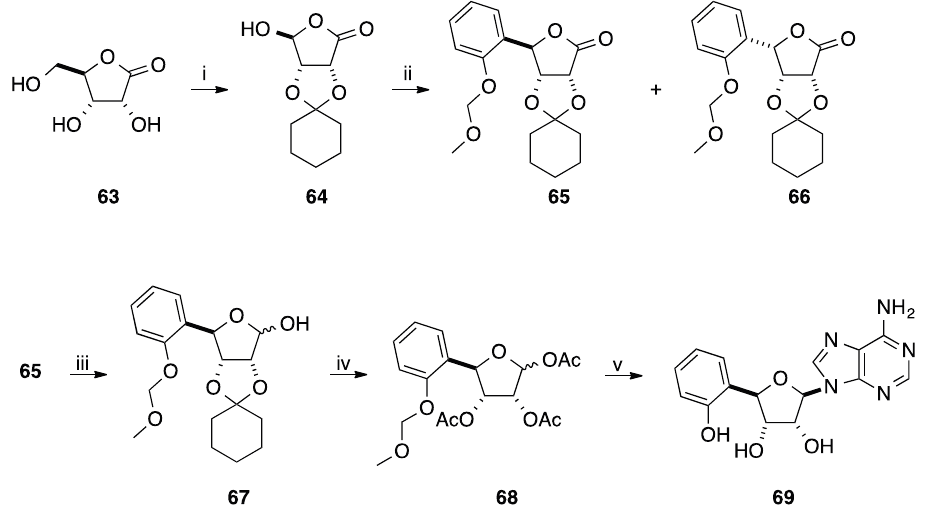
Reagents and Conditions : (i) (a) Cyclohexanone, FeCl NaIO , 0 °C then BaCl .10 H O, 4 °C, 10 min, 93%; (ii) CH 4 2 2 30%, 66 : 35%; (iii) DIBAL-H, toluene − 78 °C, 10 min, 95 %; (iv) (a) aq. HCl (0.2 M), 50 °C, 7 h; (b) Ac O, pyridine, 90% for the two steps; (v) (a) N 6 -benzoyladenine, HDMS, TMSOTf, 2 CH CN, 60 °C, 1 h; (b) NH , MeOH, rt, 48 h, 68% for the two steps. 3 3 Scheme 6. Synthesis of (4'( R )- C -phenyl- D -ribo-tetrofuranosyl)adenine analogue 69